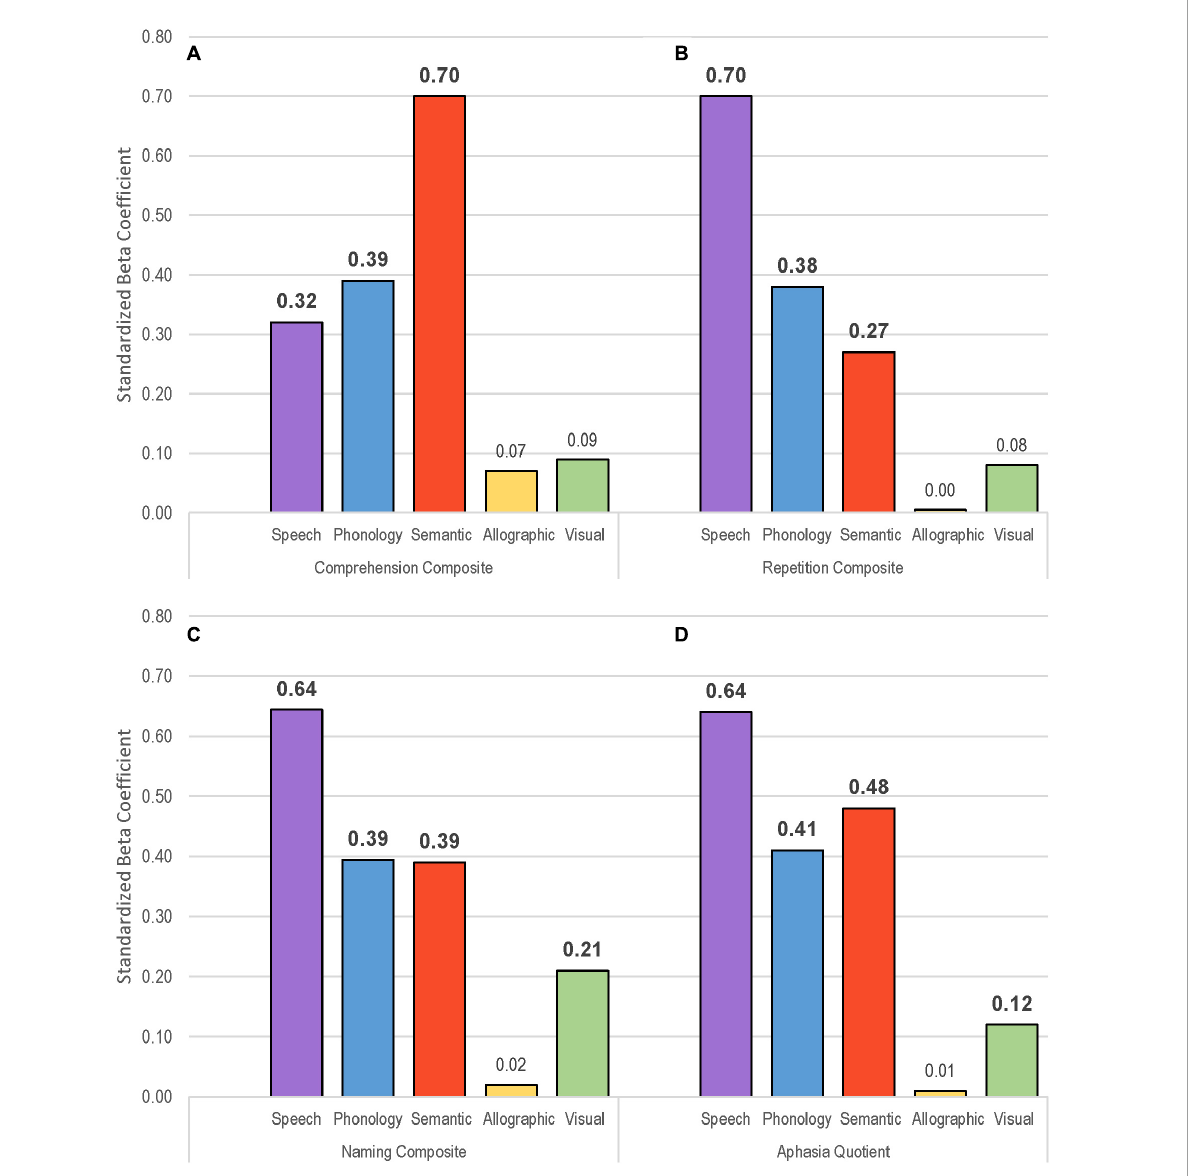
FIGURE6 Visual depiction of standardized beta coefficient values for each of five factor scores from the multiple linear regression models to the following scores from the Western Aphasia Battery: comprehension composite (A) , repetition composite (B) , naming composite (C) , and aphasia quotient (D) . Significant coefficients in